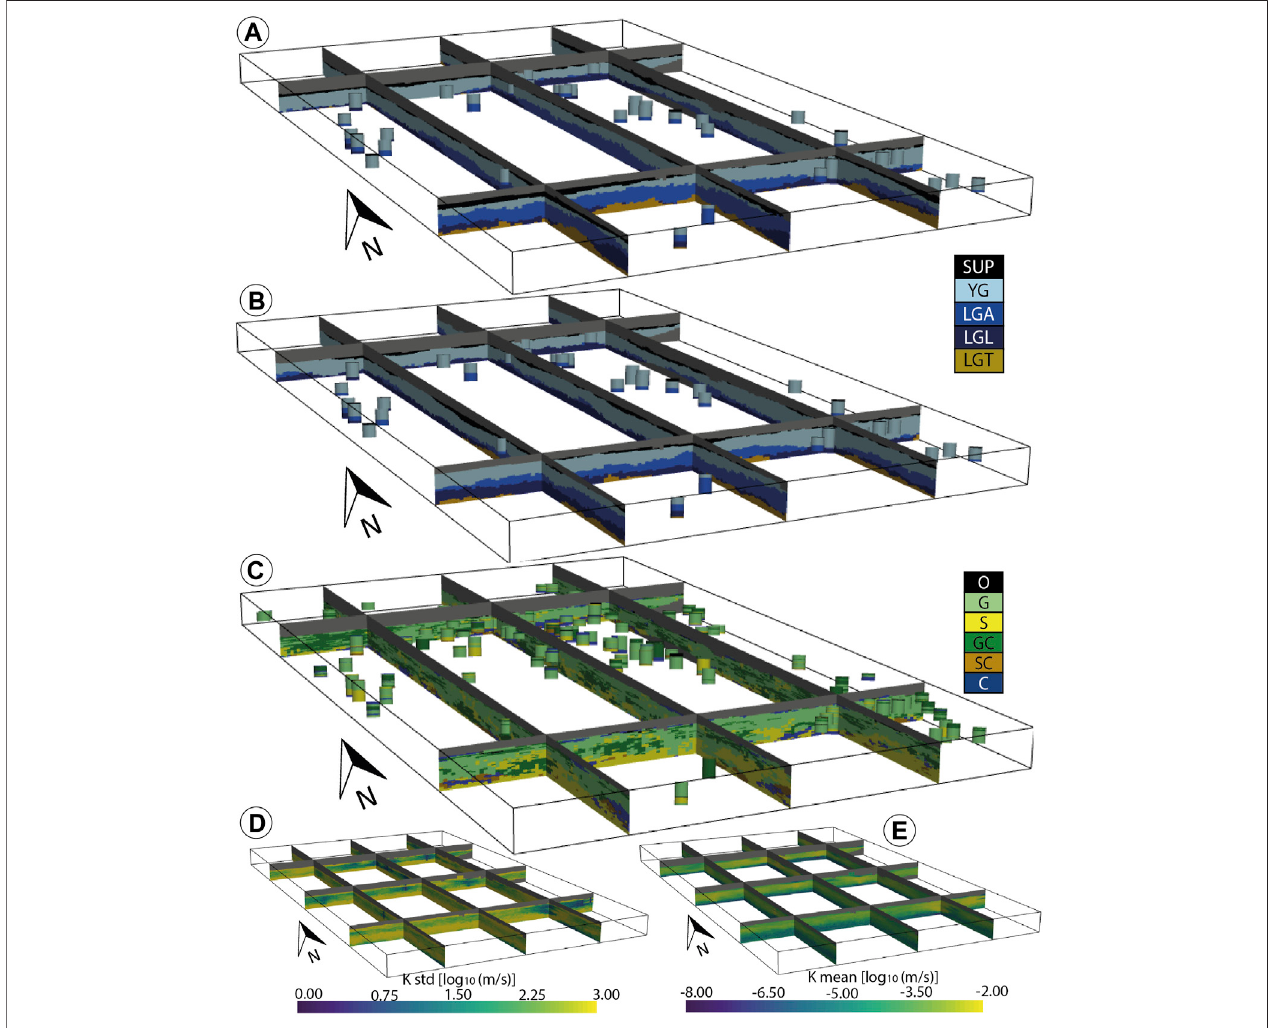
FIGURE 9 | Aare aquifer results obtained for (A,B) two unit realizations, (C) one facies realization (within model (A) ), and (D,E) K standard deviation and mean simulated along the 100 models; units are in log10 (m/s). Vertical exaggeration = 3x.